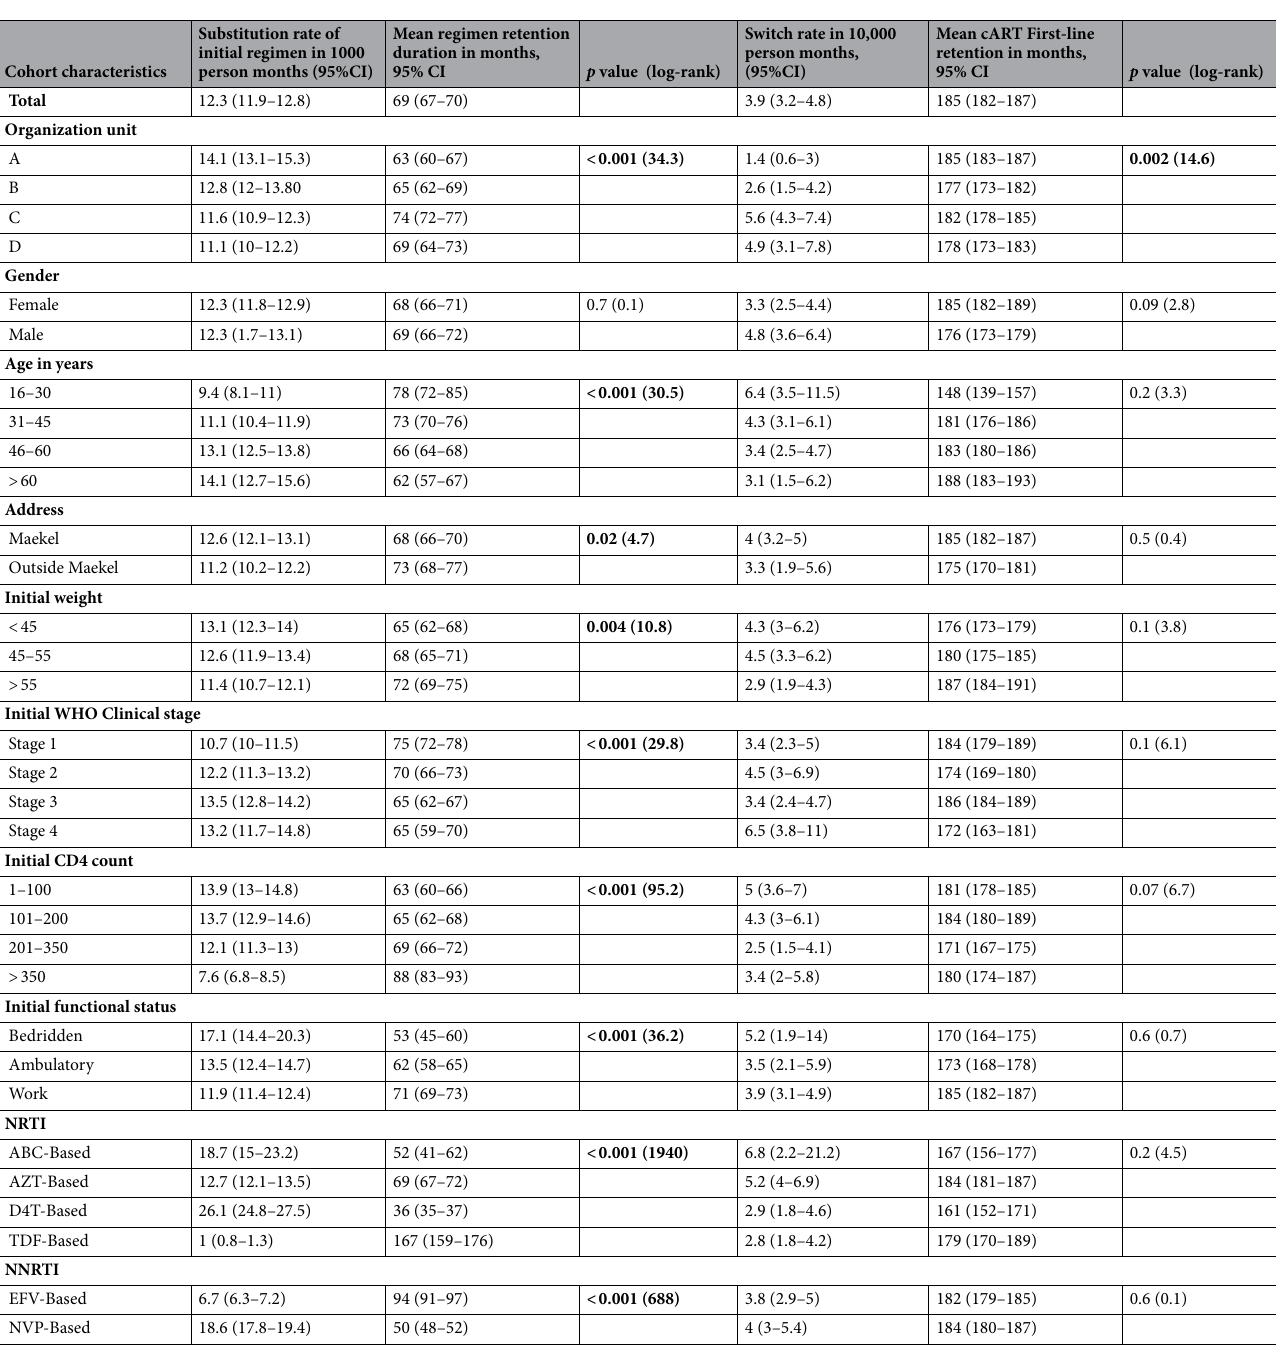
Table 2. cART regimen substitution and switch rates, Kaplan–Meier survival estimates and associated factors among PLWHA in hospitals of Asmara, 2005–2021. Significant values are in bold. TDF, Tenofovir disoproxil fumarate; FTC, Emtricitabine; AZT, Zidovudine (AZT); 3TC, Lamivudine; ABC, Abacavir; D4T, Stavudine; NVP, Nevirapine; EFV, Efavirenz. NNRTI, non-nucleoside reverse transcriptase inhibitor; NRTI, nucleoside reverse transcriptase